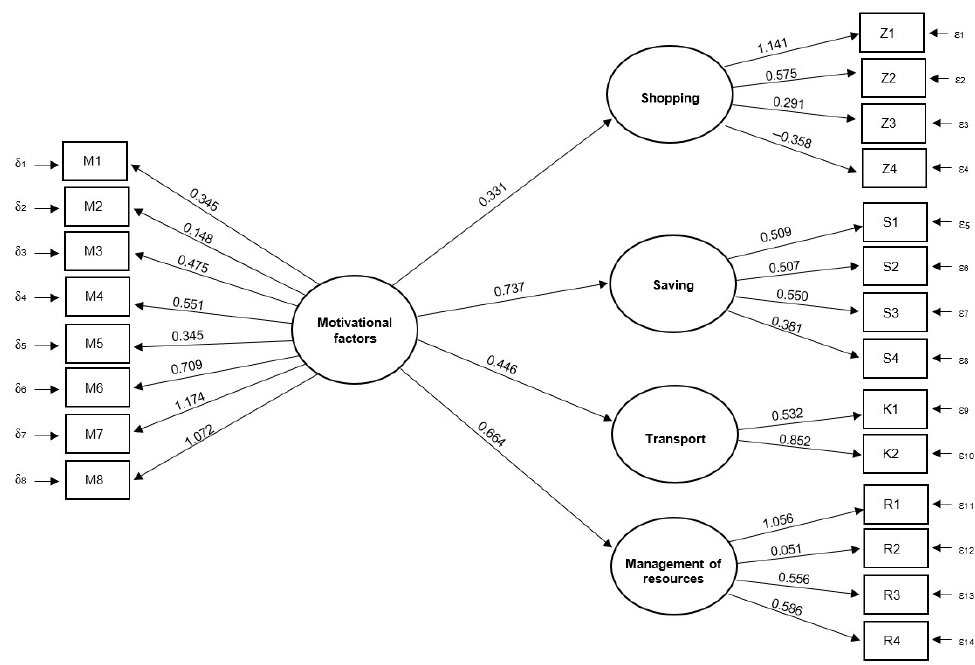
Figure 4. Estimated model of motivational factors for pro ‐ ecological behavior (Model I). Table 10. Estimated parameters of factor analysis (Model I). Relationship Evaluation Stand.